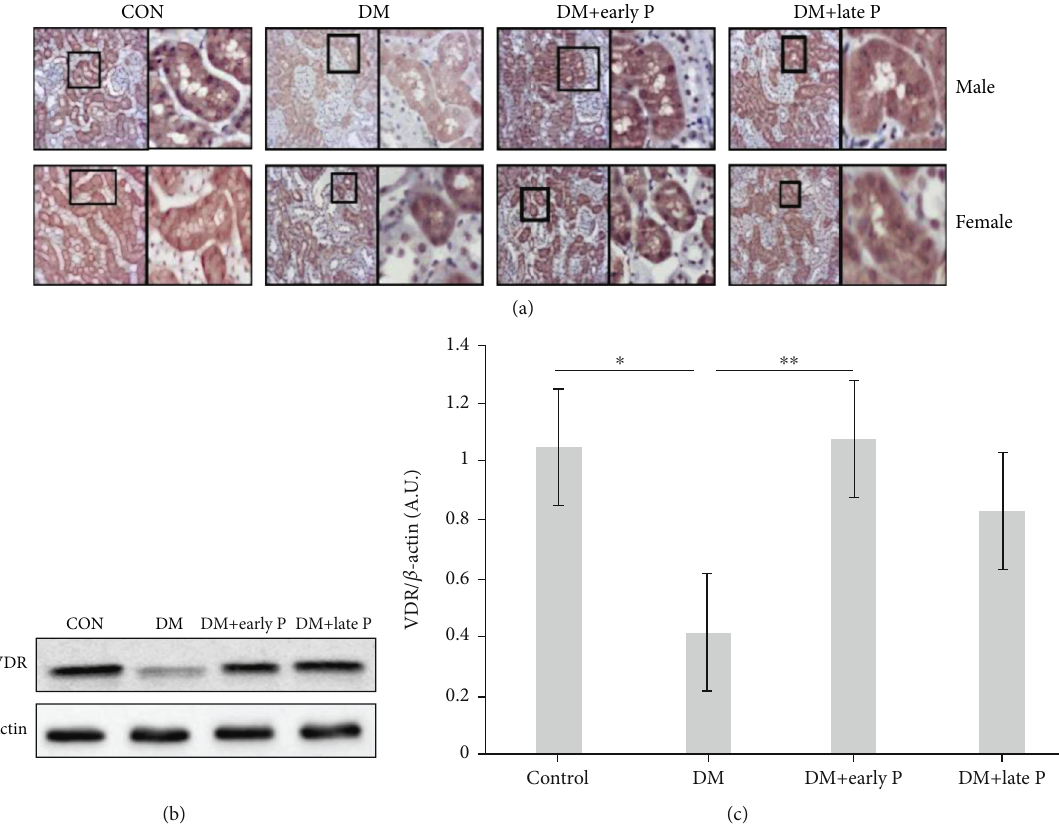
Figure 2: Vitamin D receptor expression in diabetic mouse renal tissues. (a) Immunohistochemical analysis of vitamin D receptor (VDR) expression in mouse renal tissues. VDR signals were lower in DM mice as compared to the control group. Early and late paricalcitol (P) treatments restored VDR expression to normal. Magni fi cation, × 20. (b) Representative western blots of VDR protein levels. (c) Quanti fi cation of renal VDR expression. Renal VDR was signi fi cantly decreased in DM ( n = 14 ) versus control mice ( n = 13 ) ( ∗ p < 0 : 05 ). A signi fi cant increase in VDR levels was observed in renal tissue of DM+early P ( n = 16 ) as compared to DM mice ( ∗∗ p < 0 : 01 )